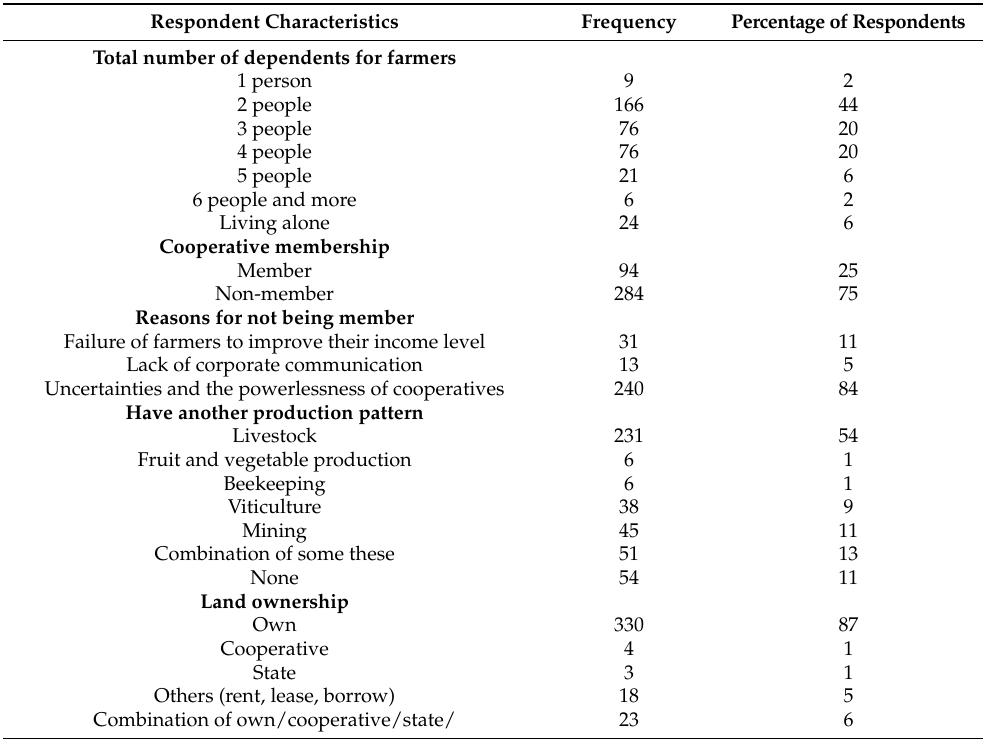
Table 3. Socioeconomic characteristics of